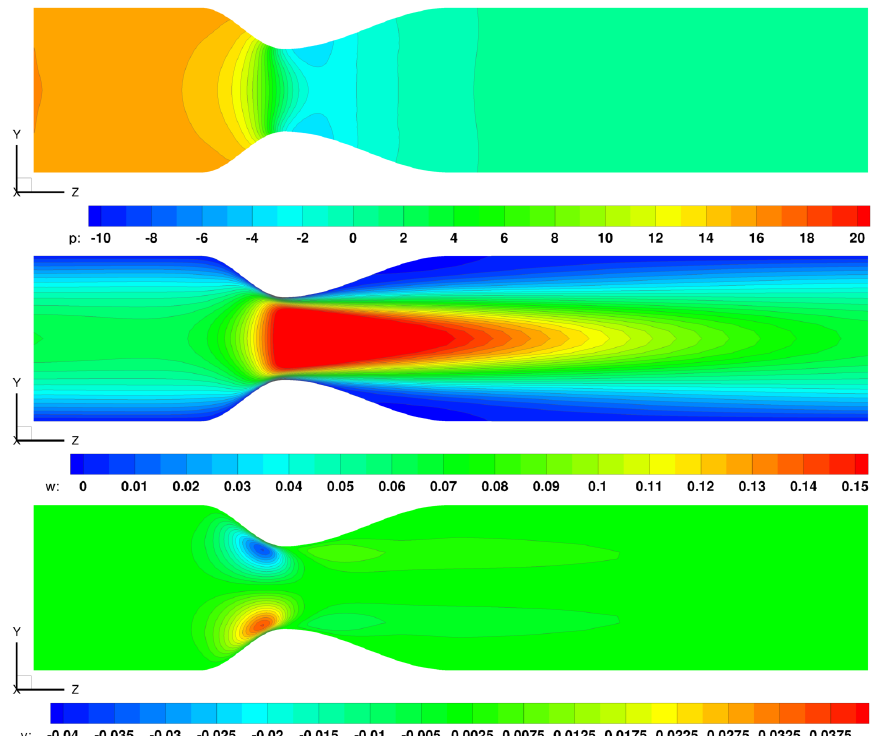
Figure 12. Flow rate Q = 1.0 cm 3 /s — Pressure, axial and radial velocity contours (from the top).